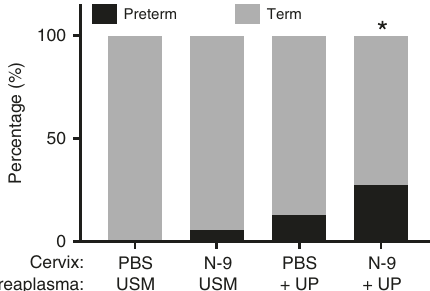
Fig. 7 Increased PTB rates in the presence of cervical damage. In the afternoon of D16 of gestation, mice received either 10% N-9 in PBS or PBS control via intravaginal inoculation. After 16 h, in the morning of D17 of gestation, mice received either Ureaplasma parvum (UP) in ureaplasma- selective medium (USM) or USM control via intravaginal inoculation.